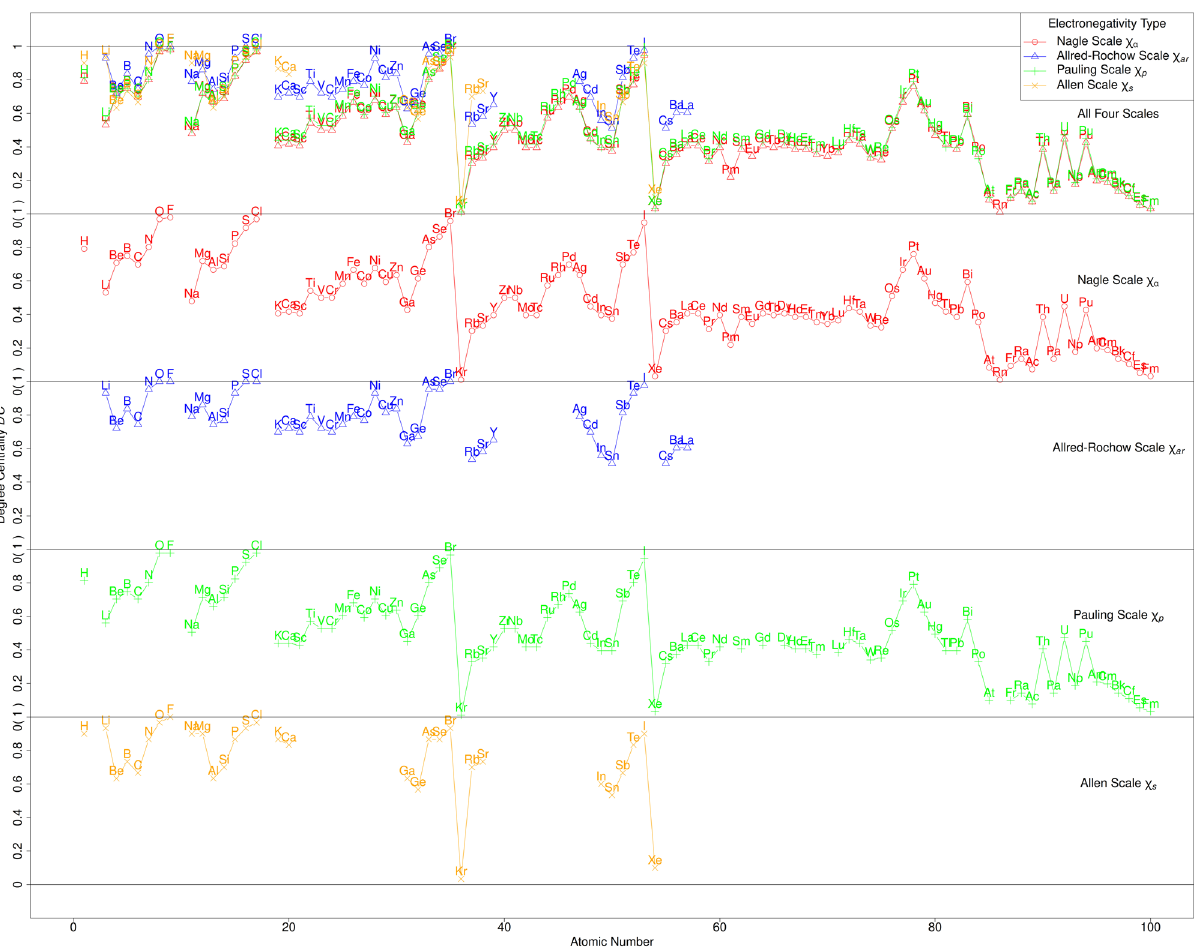
Figure 5: DC changing trends in the four